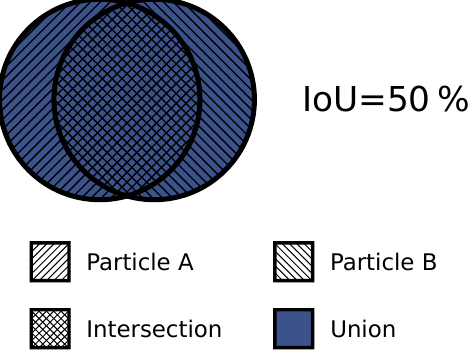
Figure 4. Illustration of intersection over union (IoU)